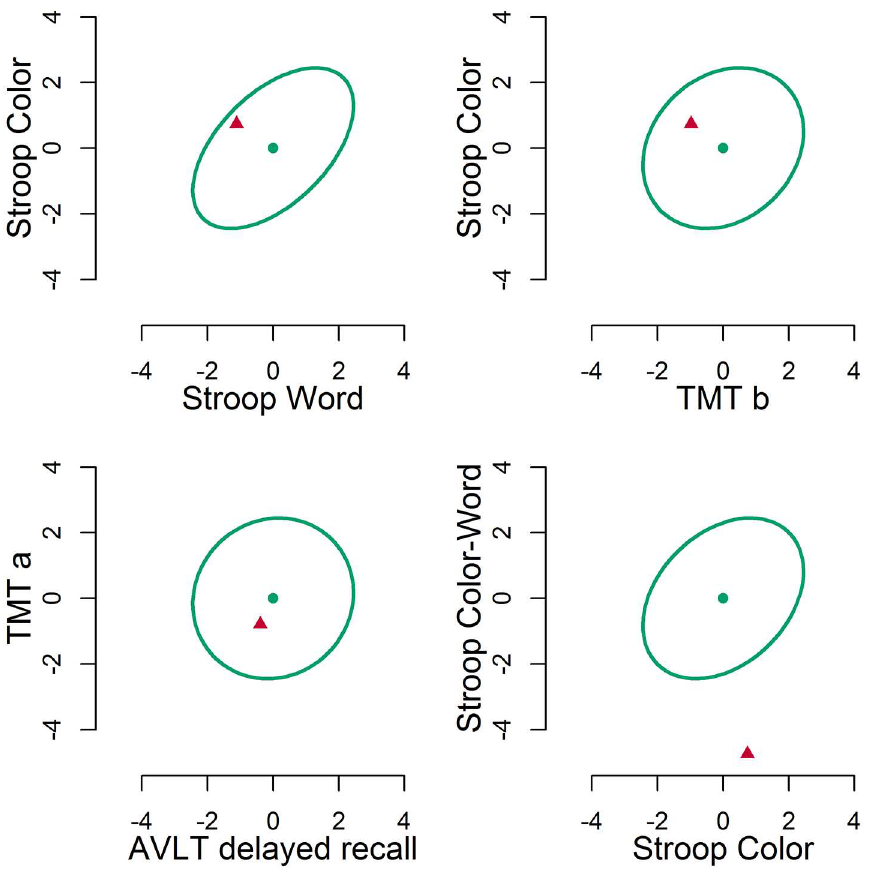
Fig 4. Four selected bivariate plots. The ellipses denotethe 95% multivariate region. The dots denote the mean score in the norm group. The trianglesdepict the patient’s